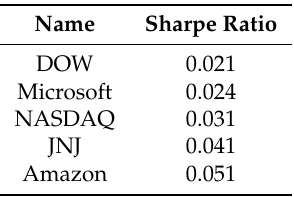
Table 10. The Sharpe Ratio in Ascending Order for the Stock Returns.